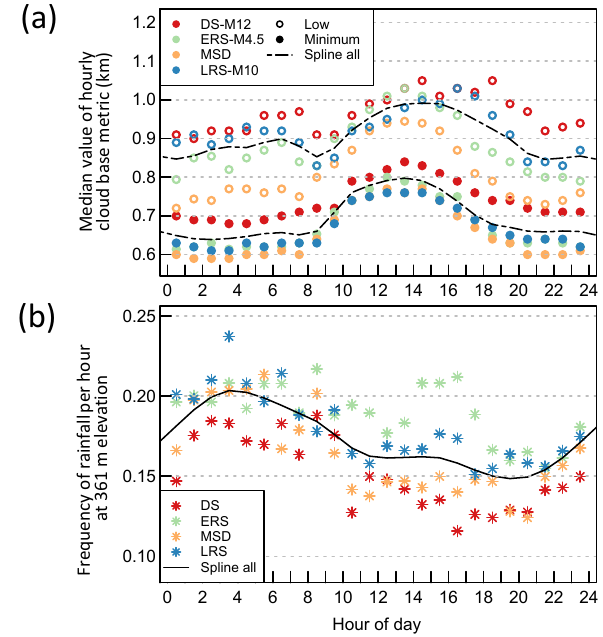
Figure 3. Summaries by hour of day for each season: (a) median al- titude of hourly low cloud bases and median altitude of hourly min- imum cloud bases from the Luquillo Experimental Forest ceilome- ter, May 2013 through August 2016, for the winter dry season with- out the month of December (DS–M12), the early rain season with- out 1–15 April (ERS–M4.5), the midsummer dry season (MSD), and the late rain season without October (LRS–M10); (b) frequency measurable rainfall occurred in each hour of the day for 2000–2016 for the Bisley station at 361m elevation during the seasons without excluded months. Colored symbols are seasonal values and black lines are the cubic smoothing splines of all data in the ceilometer period of